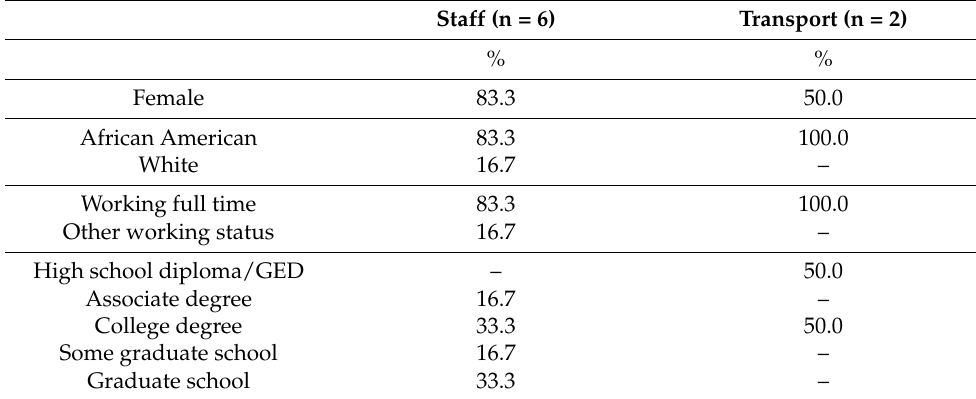
Table 2. Characteristics of TRIP Staff & Transportation Companies (N =